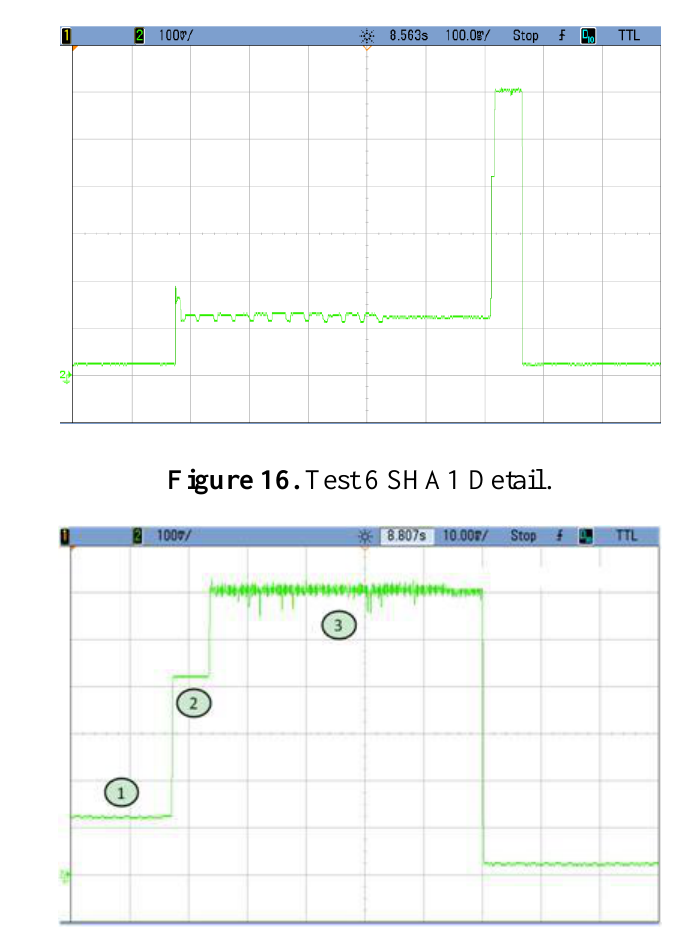
Figure 15. Test 6 SHA1.